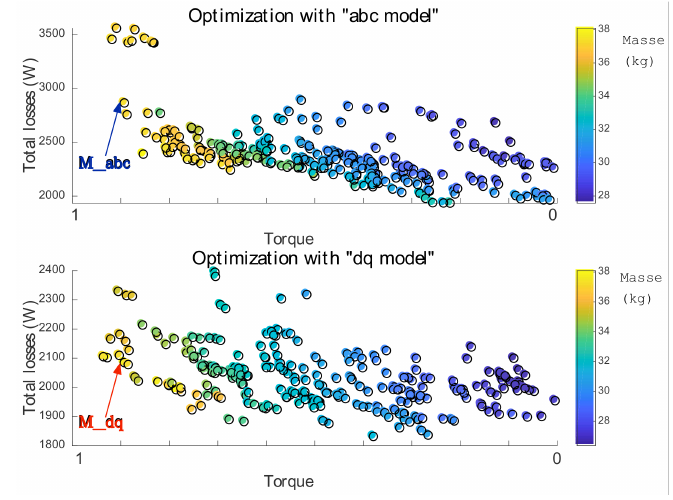
Figure 16. Pareto Front of optimization results with “abc model” and “dq model”.